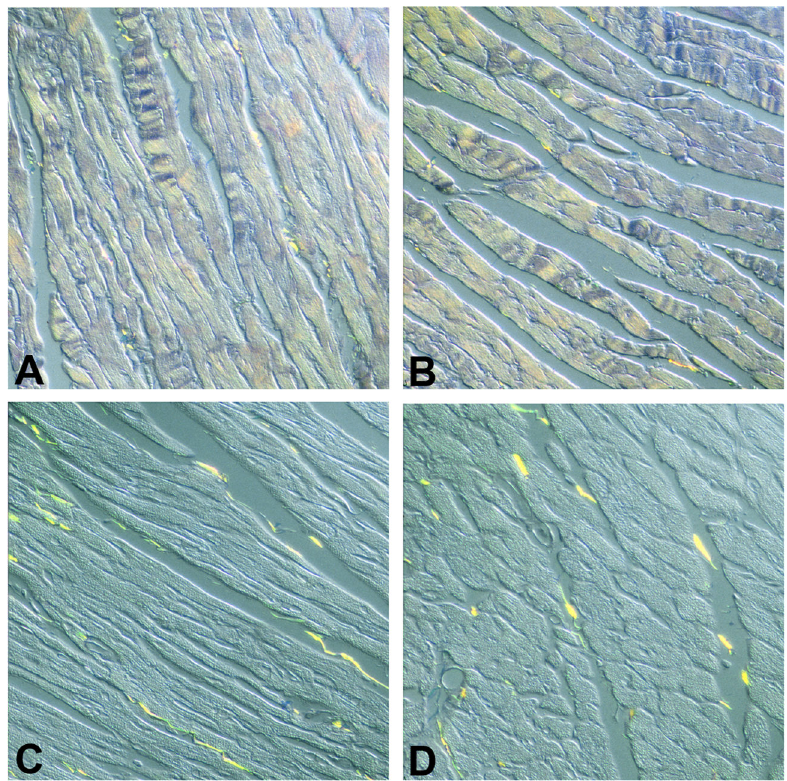
Figure 6. Assessment of cardiac interstitial collagen accumulation in WT and NTT-MMP-2 transgenic hearts. Picrosirius Red staining of four month old WT (panel A) and NTT-MMP transgenic ventricular sections (panel B). There is minimal interstitial collagen detected in either group. At twelve months of age there are minor, and equivalent, increases in interstitial collagen in the WT and NTT-MMP TG hearts cf. panels C, D). (X250). doi: